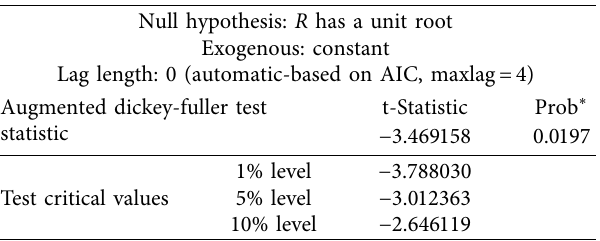
Table 6: The stationarity test results of residuals of GDP and fiscal expenditure data from 1998 to